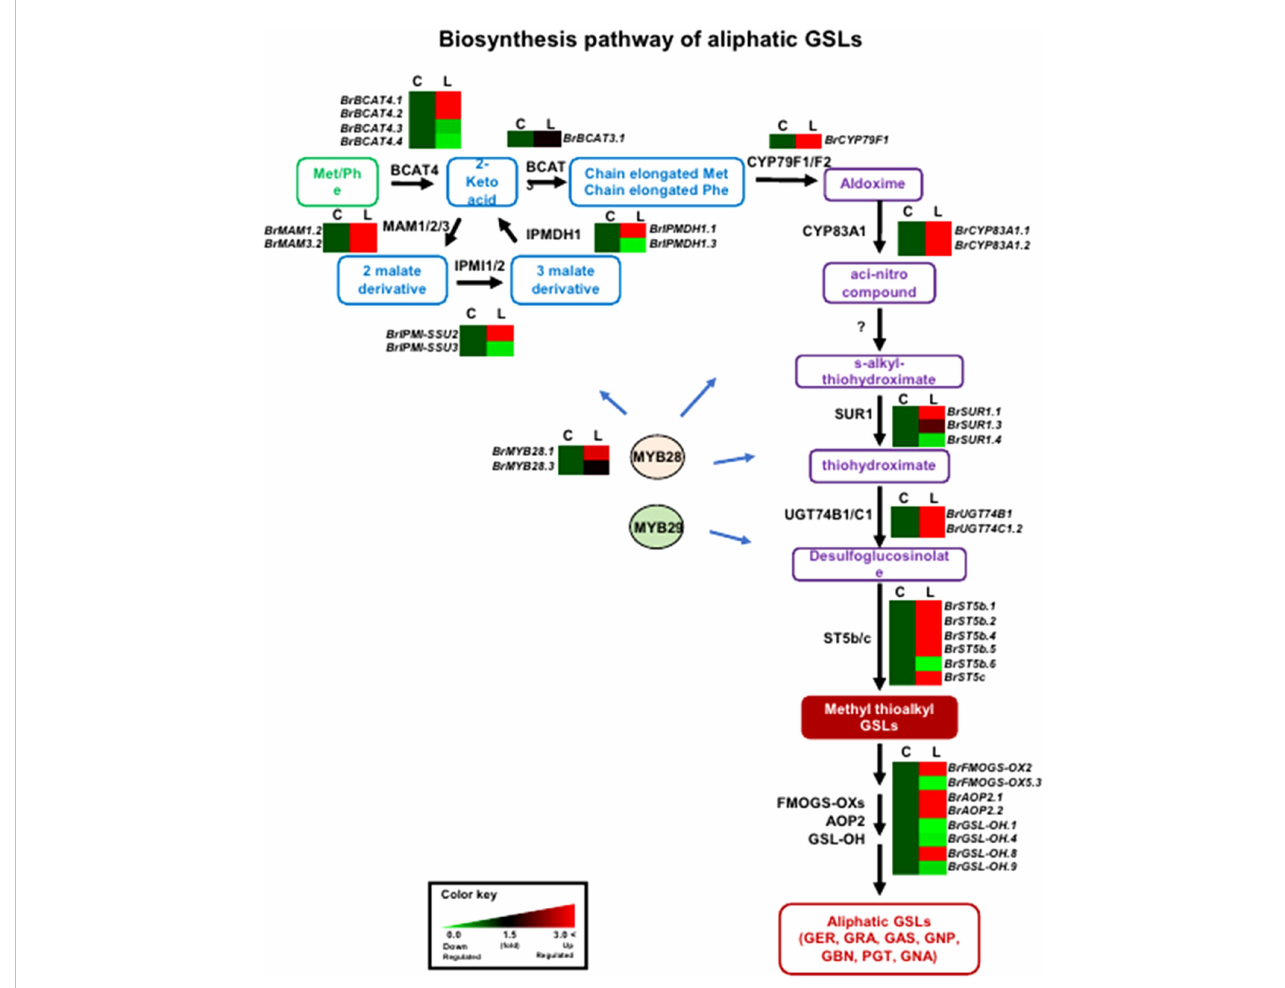
FIGURE 4 Comparison of expression pro fi les of GSL metabolic genes involved in aliphatic GSL biosynthesis. Schematic representation of aliphatic GSL metabolic pathways and expression patterns of aliphatic GSL pathway genes in ‘ Chiifu ’ and ‘ LP08 ’ . The aliphatic GSL biosynthetic pathway begins with side-chain elongation of precursor amino acids such as methionine (Met) by catalytic enzymes such as BCAT4. Black letters between paths refer to genes associated with each step. B . rapa MYB TFs, such as BrMYB28s ( BrMYB28.1 and BrMYB28.3 ), boost the expression of aliphatic GSL metabolic genes. Compared to ‘ Chiifu ’ , BrMYB28s and downstream GSL metabolic genes are more abundantly expressed in ‘ LP08 ’ . For comparative heatmap analysis of ‘ Chiifu ’ and ‘ LP08 ’ , the level in ‘ Chiifu ’ was set to 1 and the relative level of each gene in ‘ LP08 ’ is presented on the right side. C: Chiifu, L: